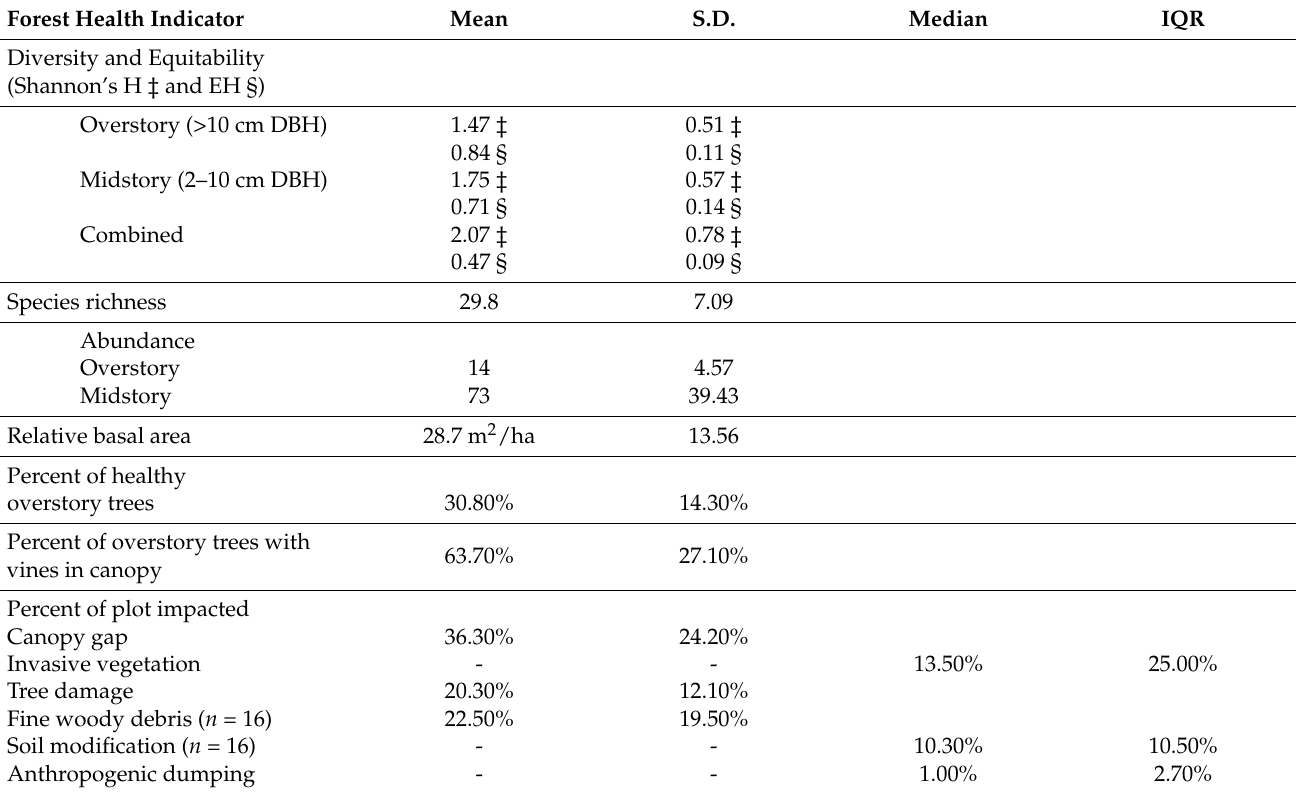
Table 1. Forest health indicators used in this study, derived from ecological field measurements taken at each of the 17 sampling plots (unless otherwise indicated). Note that values of Shannon’s H and Equitability are indicated by ‡ and §, respectively. S.D. = standard deviation. Median and interquartile range are presented for non-normally distributed